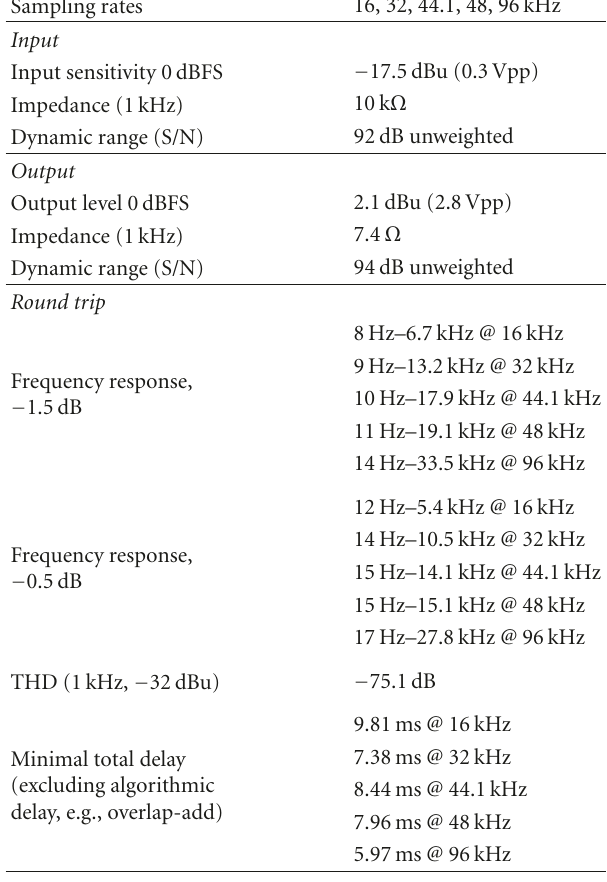
Table 2: Speech recognition threshold (SRT) improvement (i.e., di ff erence to identity processing with hearing loss correction “REF”) in dB SNR for the four algorithms, measured at four test sites. The standard deviation across test site is marginal, which proves the reliability of the PHS prototype as a research and field testing hearing system, data from [7].